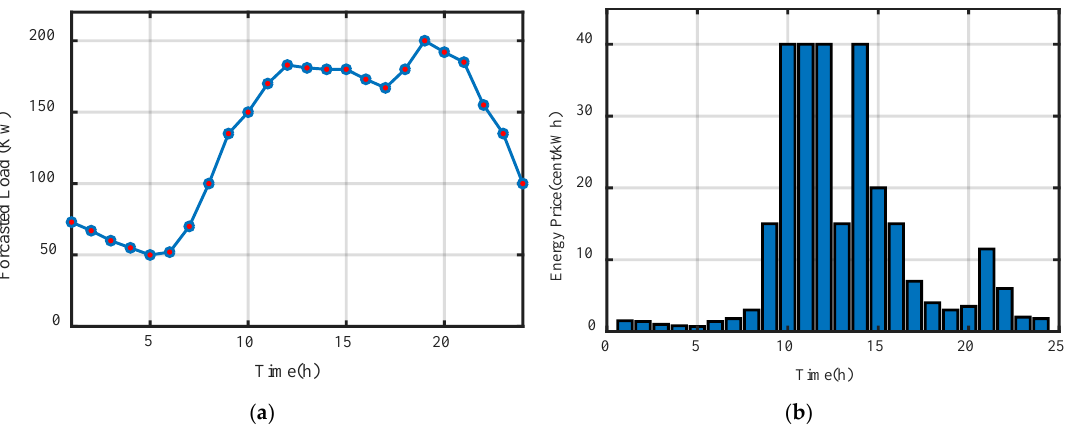
Figure 6. ( a ) The forecasted load for 24 h in the underlying microgrid; ( b ) time-of-use price for a 24 h period [47].